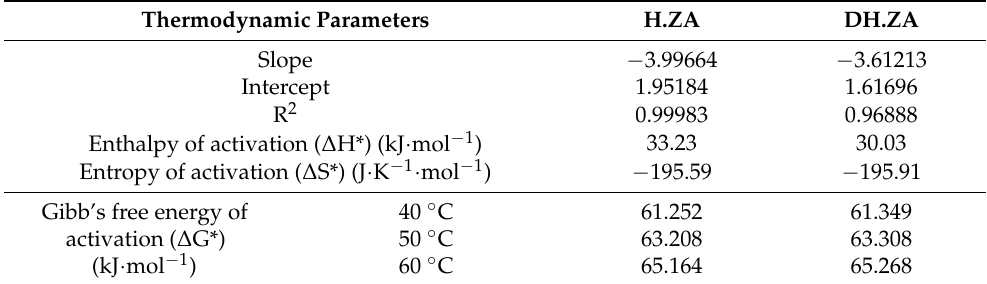
Table 5. Evaluation of thermodynamic parameters from Eyring–Polanyi plot: ln(K C /T) vs. 1/T × 10 − 3 . Thermodynamic